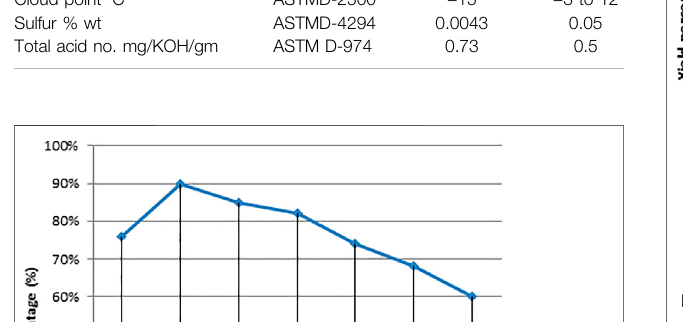
FIGURE 6 | Effect of temperature variation on the Dodonaea biodiesel production yield.